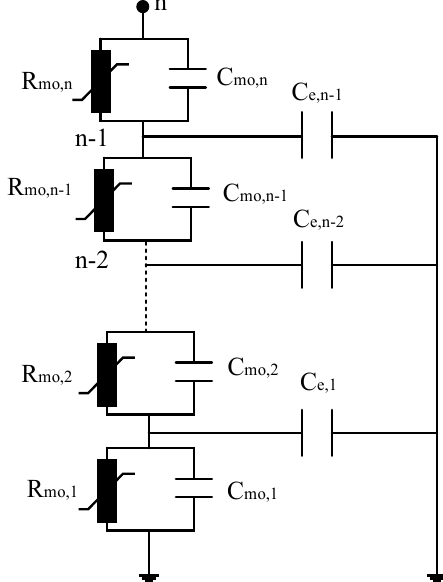
Figure 1. Simplified multi-stage equivalent circuit of an arrester (R mo,x : voltage-dependent resistance of section x, C mo,x : capacitance of section x, C e,x : stray capacitance to earth at node x, n: number of sections).